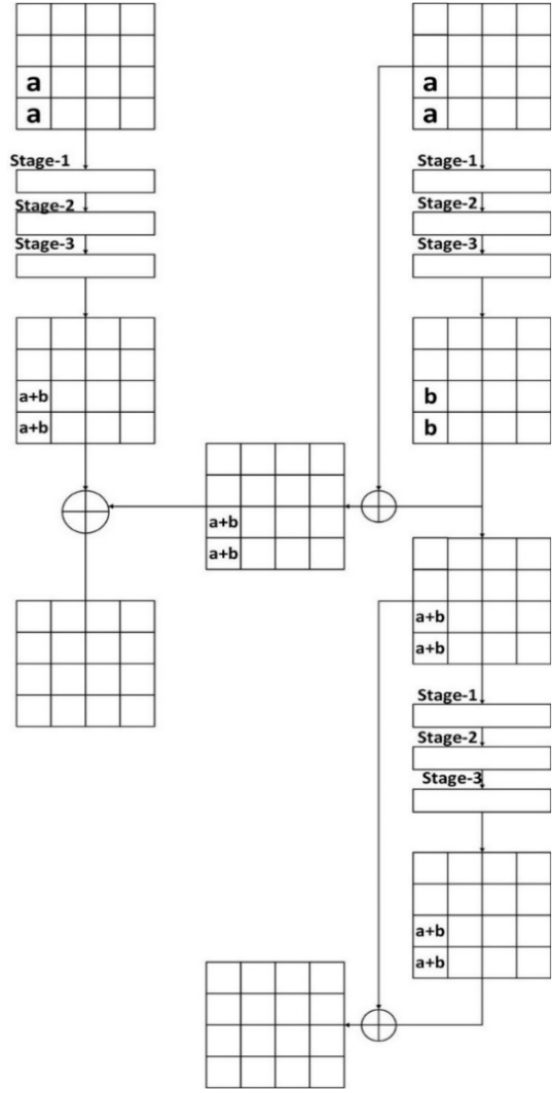
Figure 7. Difference conversion scheme for the HBC-256 hashing function.